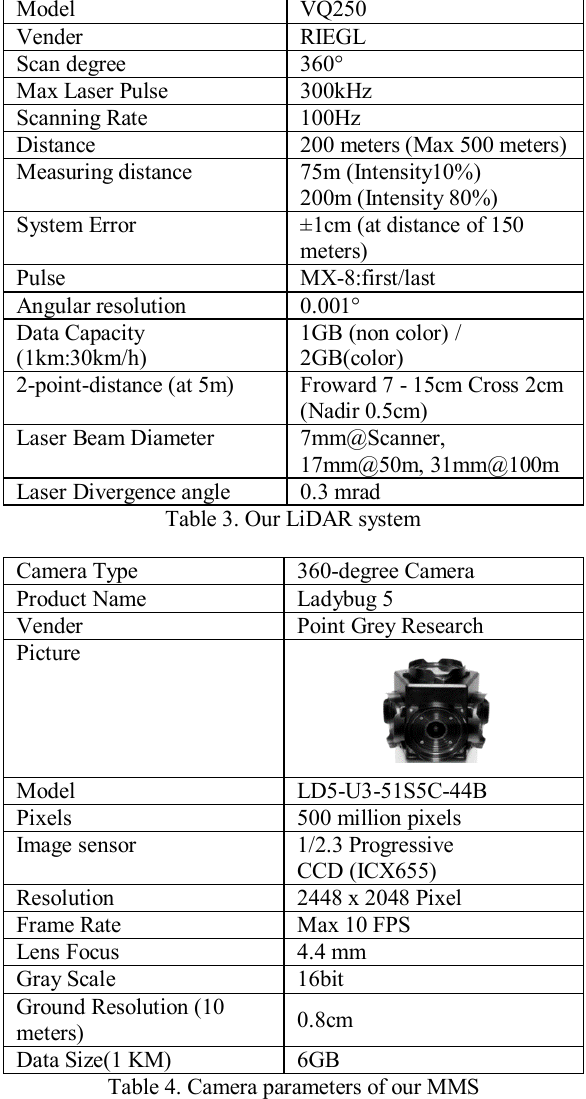
Table 4. Camera parameters of our MMS